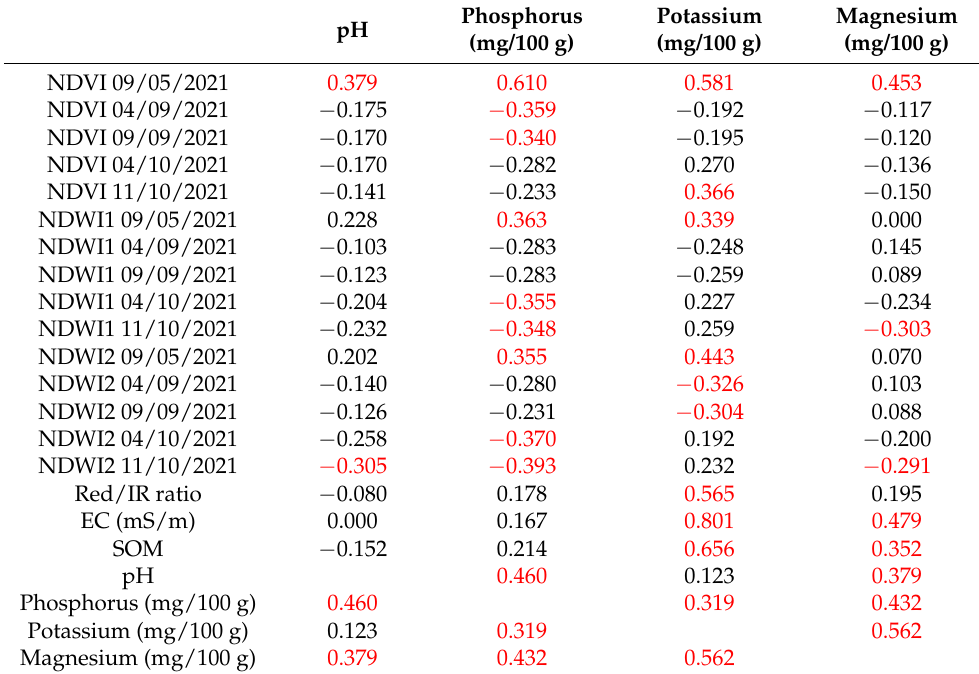
Figure 2. Nutrient content in soil and pH in study area.